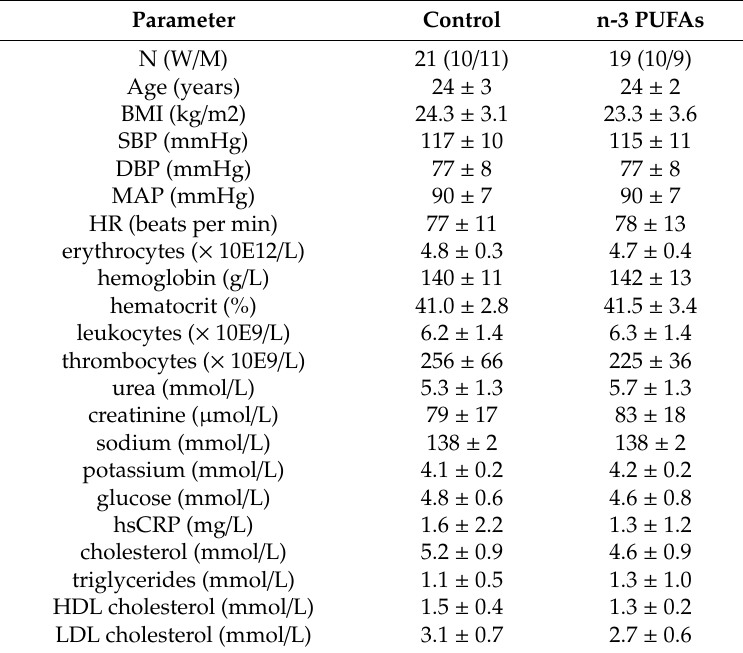
Table 1. Initial clinical characteristics of study